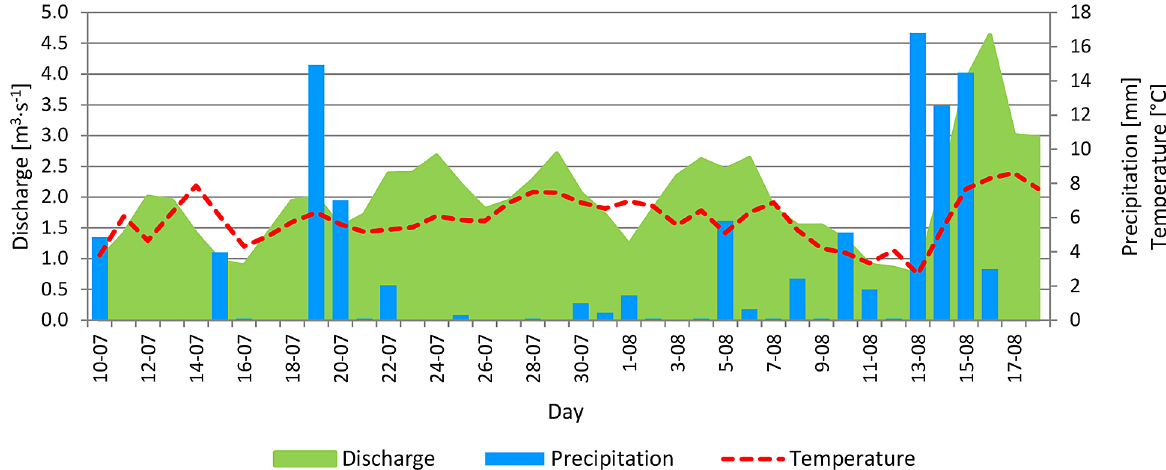
Fig. 4. Course of mean daily discharges in the Scott River in comparison to daily precipitation and air temperature in the measurement period